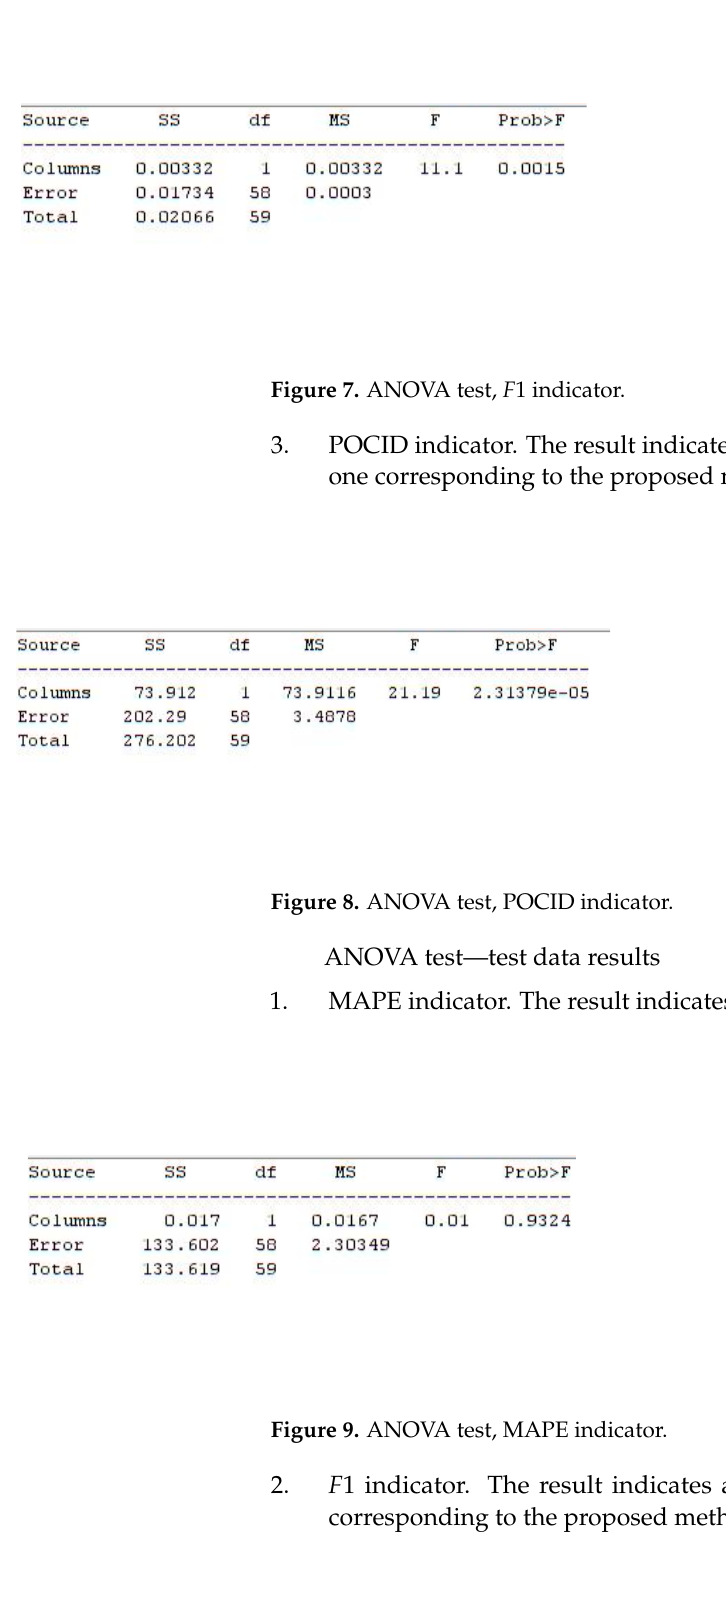
Figure 6. ANOVA test, MAPE indicator.